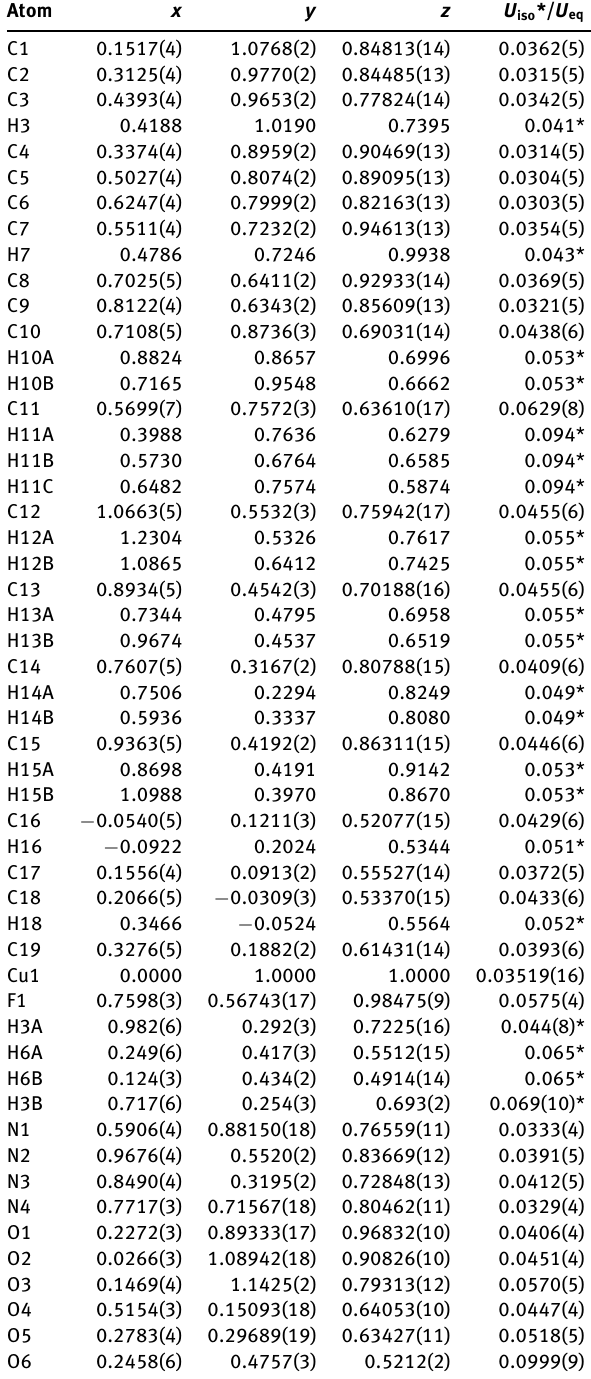
Table 2: Fractional atomic coordinates and isotropic or equivalent isotropic displacement parameters (Å 2